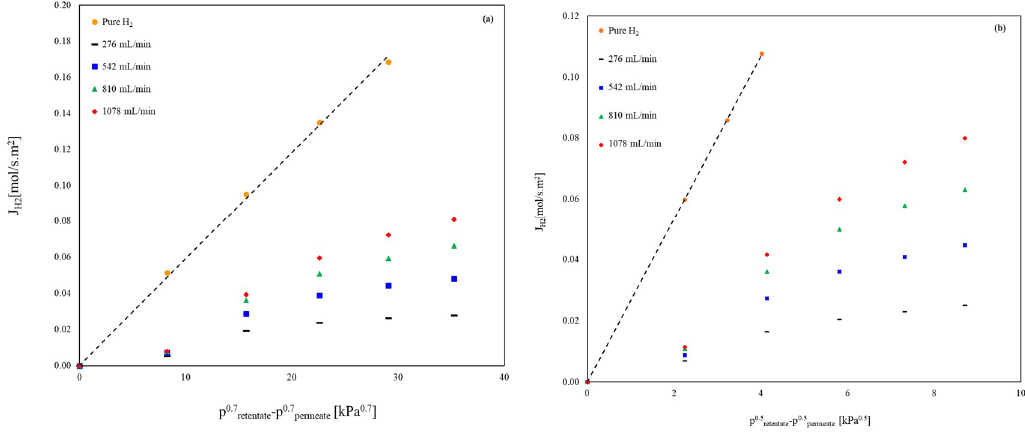
Figure 6. Influence of feed flow rate on the permeation flux of H 2 in ( a ) Pd/YSZ and ( b ) Pd-Au/Al 2 O 3 membranes.